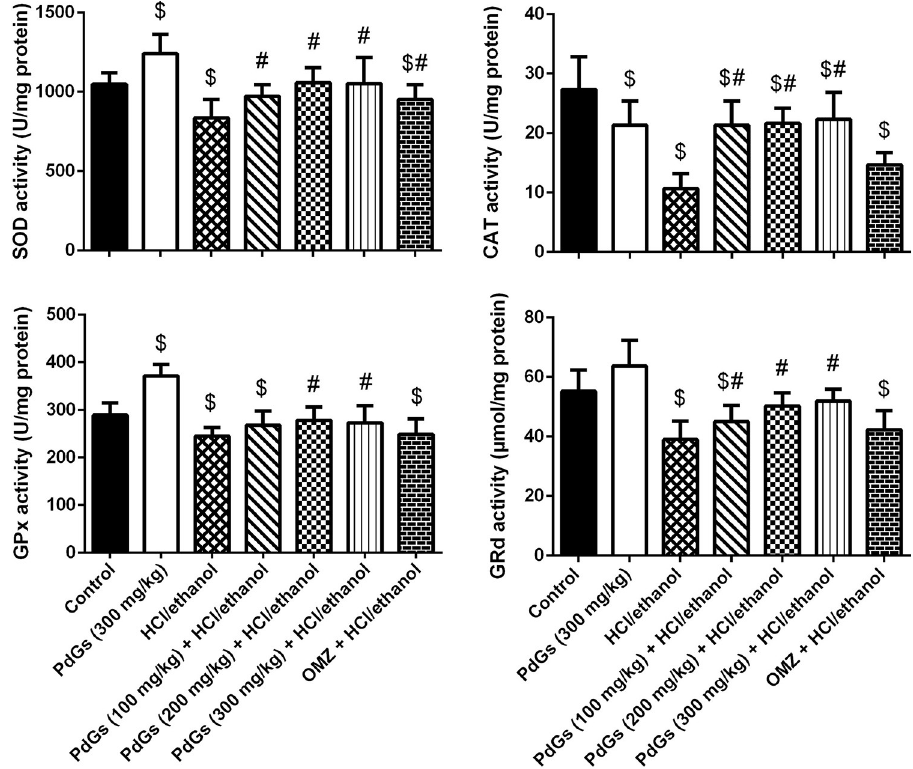
Fig 9. Effect of prodigiosins on SOD, CAT, GPx, and GRd activities in gastric tissue. Data are expressed as the mean ± SEM of 6 rats. a P < 0.05, significant difference vs . the health rats; b P < 0.05, significant difference vs . HCl/ ethanol-induced rats, Duncan’s post-hoc